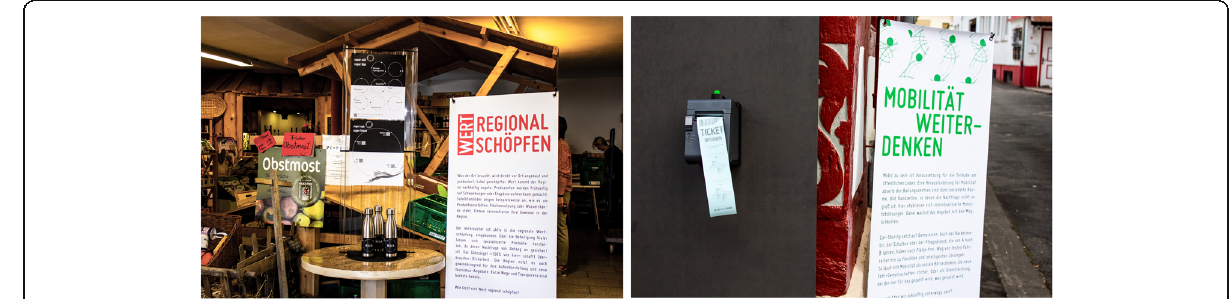
Fig. 4 Selected images from the needs assessment workshops © Fraunhofer